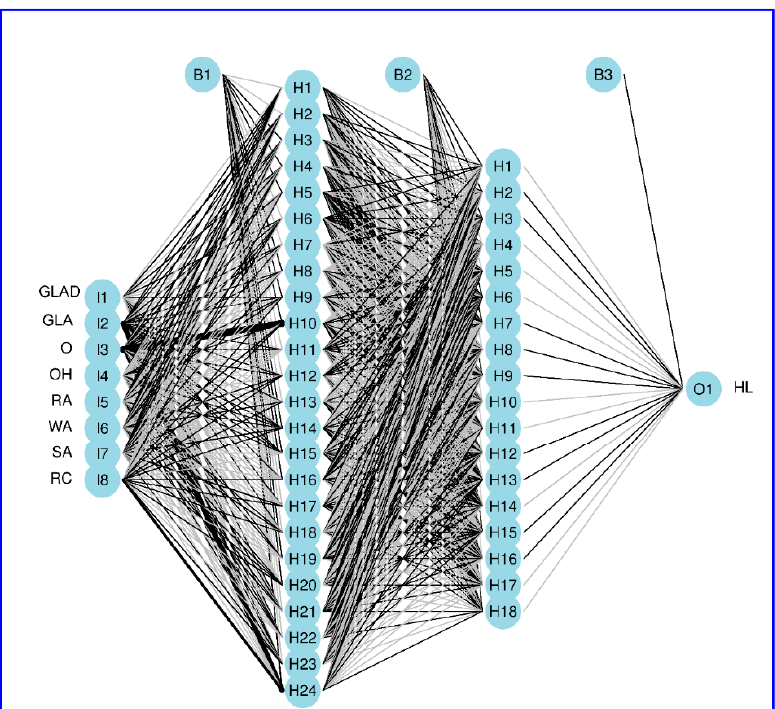
Figure 15. Structure of the ICA-ANN model for estimating HL of EEB systems.